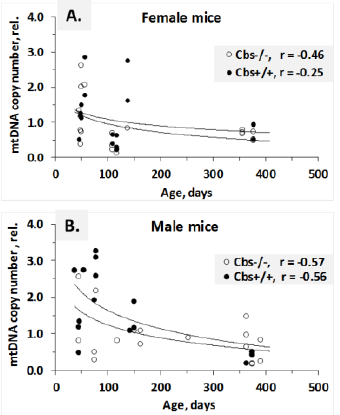
Figure 3. Relationships between blood mtDNA copy number and age in female ( A ) and male ( B ) Cbs −/− and Cbs +/− mice. ♀ Cbs −/− ( n = 11), ♂ Cbs −/− ( n = 10), ♀ Cbs +/− ( n = 10), and ♂ Cbs +/− ( n = 13). Logarithmic trendlines fitted to the data points are shown. rel. = relative